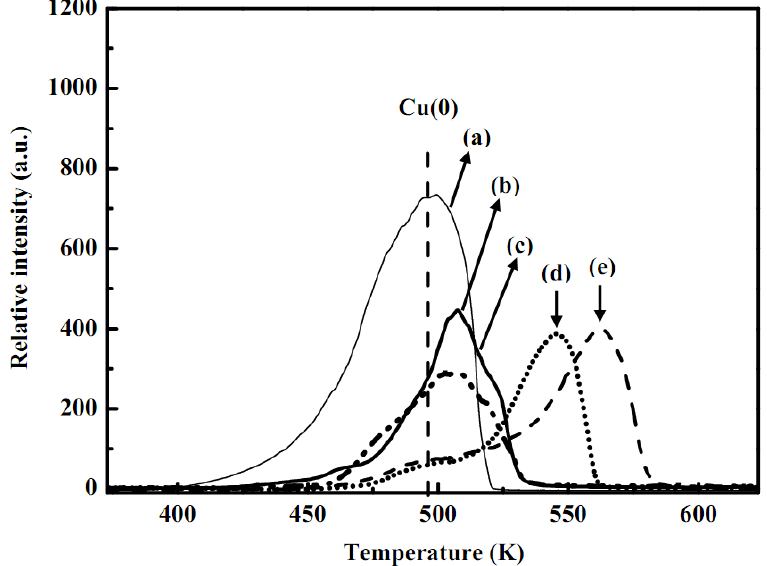
Figure 4. TPR curves of: (a) metallic copper, (b) fresh CuO/ZnO-Al synthesized CuO/ZnO-Al O catalyst at pH 4 mixed with ZrO 2 3 20-R 10-pH4.0-St0.5), (d) 6 h (S (c) 30 min (S C C/B CuO/Al O standard (notes: Sc: solid content of (catalyst + binder) / total weight of 2 3 (catalyst + binder + sol) (wt. %); R : solid weight ratio of catalyst to binder (wt. %); pH: C/B pH value of washcoat slurry; St: stirring